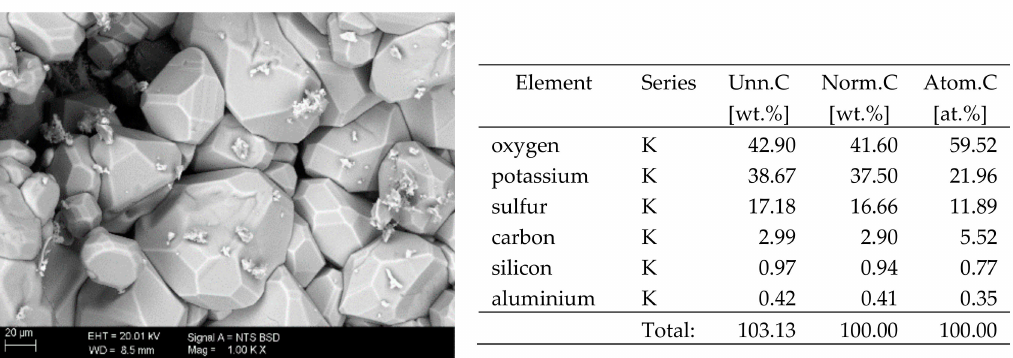
Figure 7. SEM image of the microstructure of MgSO 4 crystals visible on the surface of the bricks tested; 1000 × magnification. Next to it is a screenshot an EDS analysis for presence of crystals.